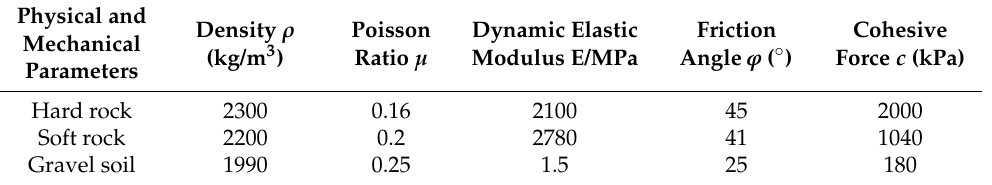
Figure 6. Schematic diagram of the boundary conditions of the numerical model. Table 1. Physico-mechanical parameters of the material parameters of the sites [9,20].